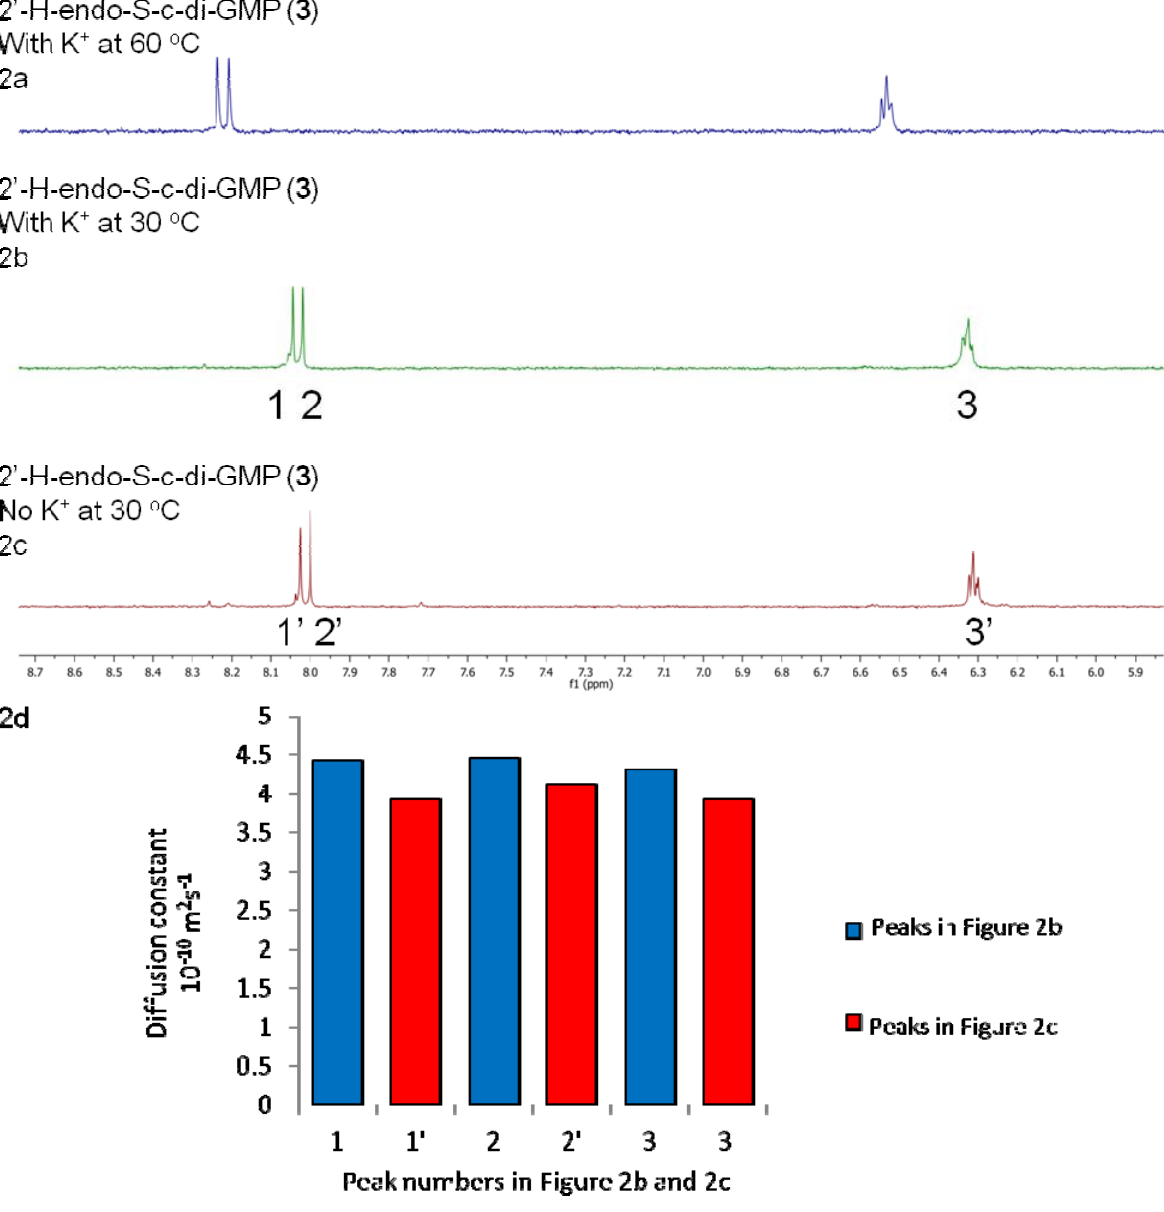
O. ( a ) 3.0 mM 2'-H-endo- 2